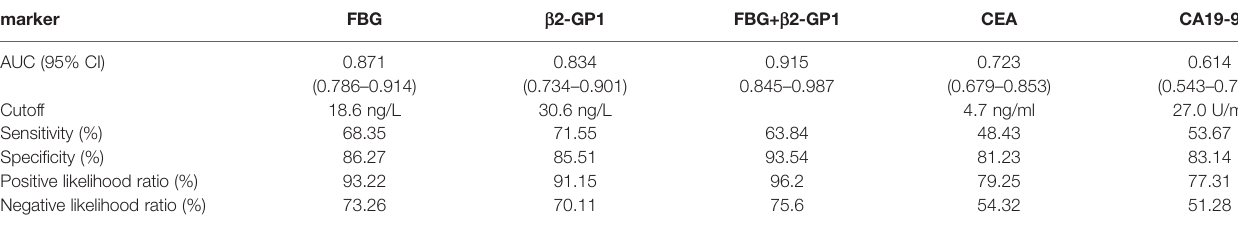
TABLE 2 | ROC of plasma exosomal glycoproteins as biomarkers for early diagnosis of CRC.